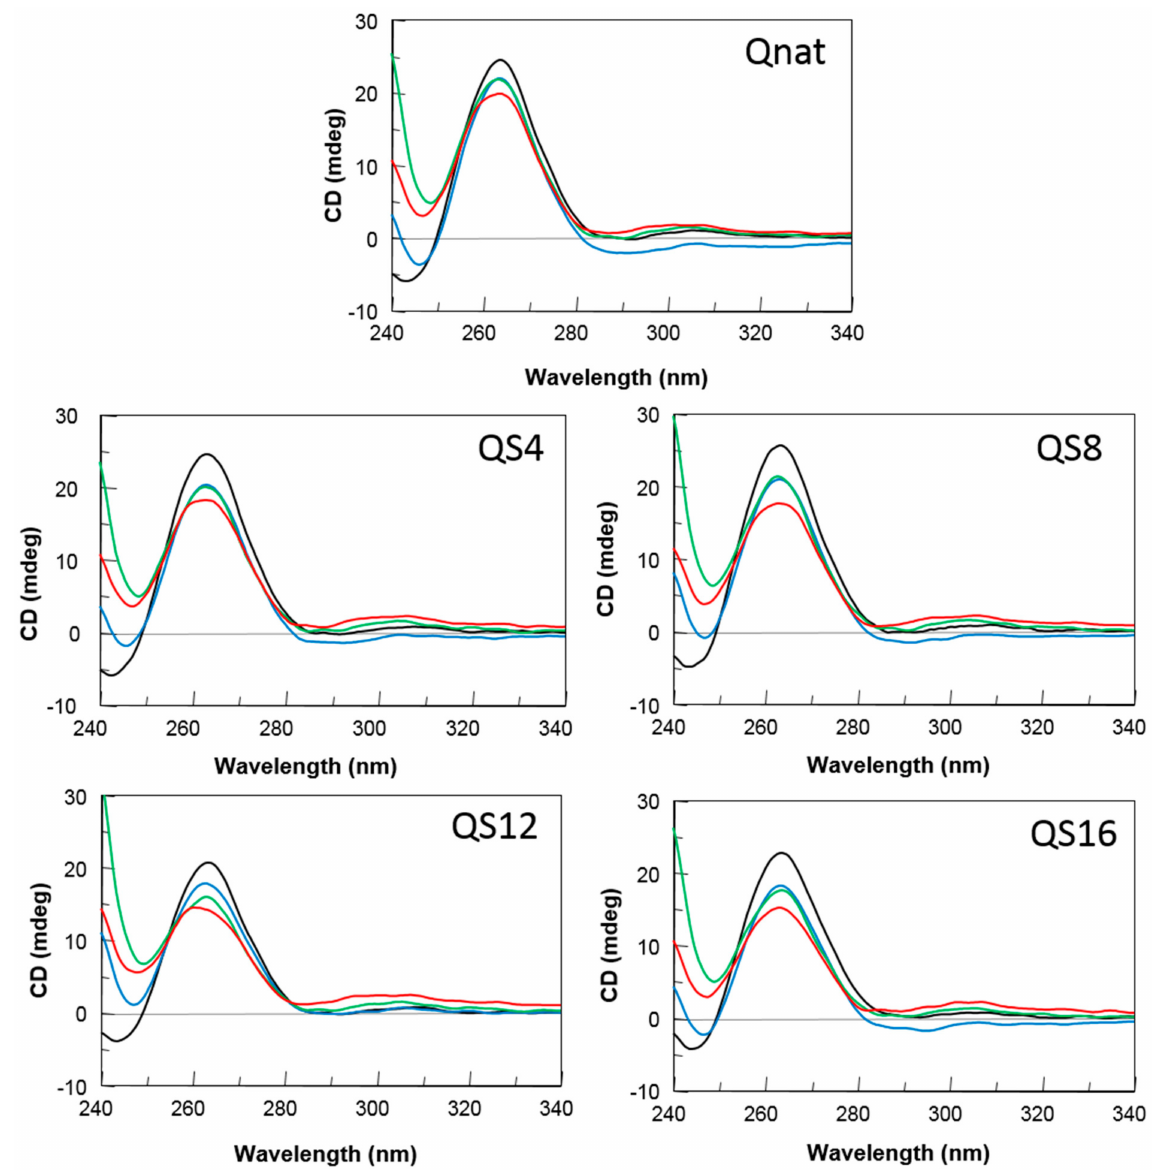
Figure 3. CD spectra of Qnat and its analogues in 10% fetal bovine serum (FBS) diluted with Dulbecco’s Modified Eagle’s Medium (DMEM), registered at 0 (black), 24 (blue), 48 (green), and 72 h (red) at 37 ◦ C. See the main text and the Materials and Methods section for